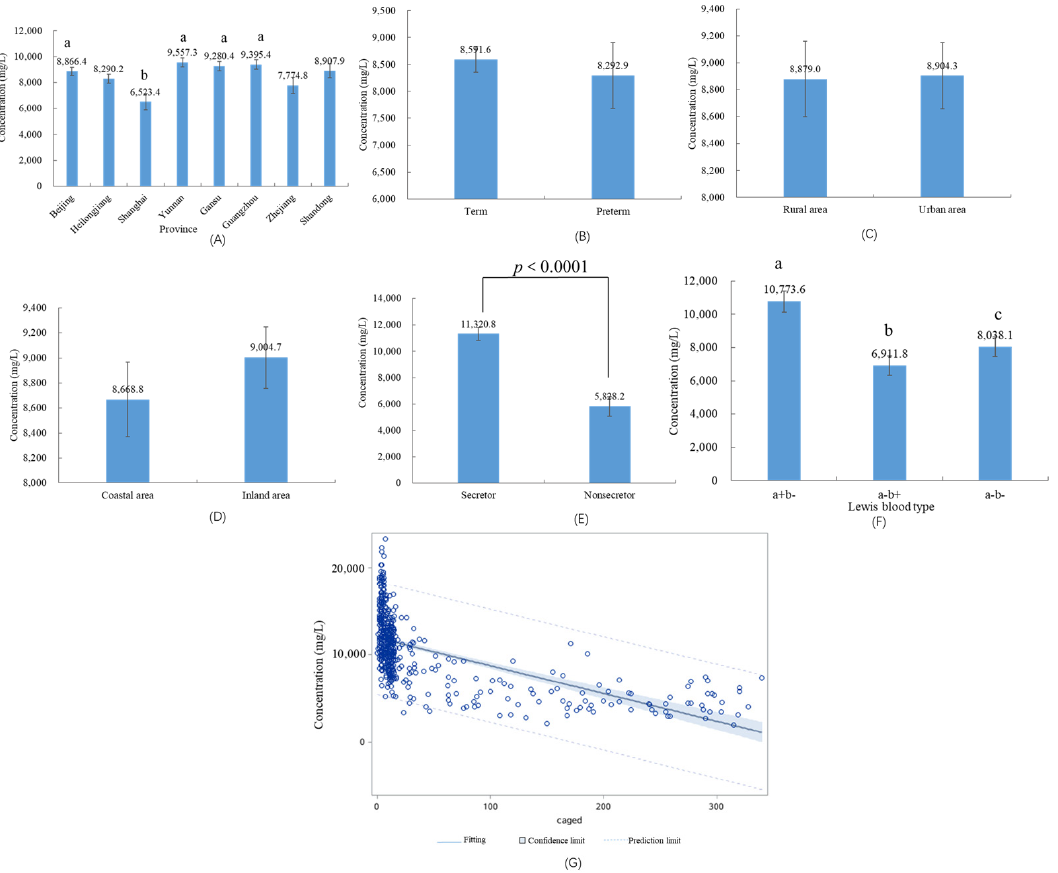
Figure 4. Concentrations of total oligosaccharides in different influencing factors: ( A ) different provinces; ( B ) preterm and term; ( C ) rural areas and urban areas; ( D ) coastal areas and inland areas; ( E ) active secretor gene and inactive secretor gene; ( F ) Lewis blood type; ( G ) lactation days. Data are shown as mean ± SE. Small letters indicate significant differences ( p < 0.05). Brackets with numbers indicate fi gure number.